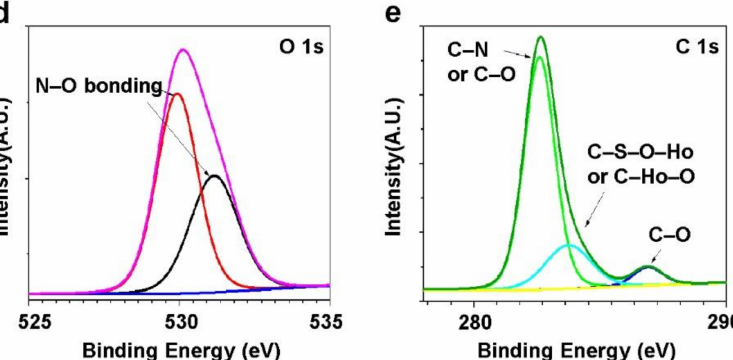
Figure 2. ( a ) Typical TEM image of the Ho-oxide nanoparticles. High resolution of XPS spectra for different elements: ( b ) Ho 4d; ( c ) N 1s; ( d ) O 1s; ( e ) C 1s.